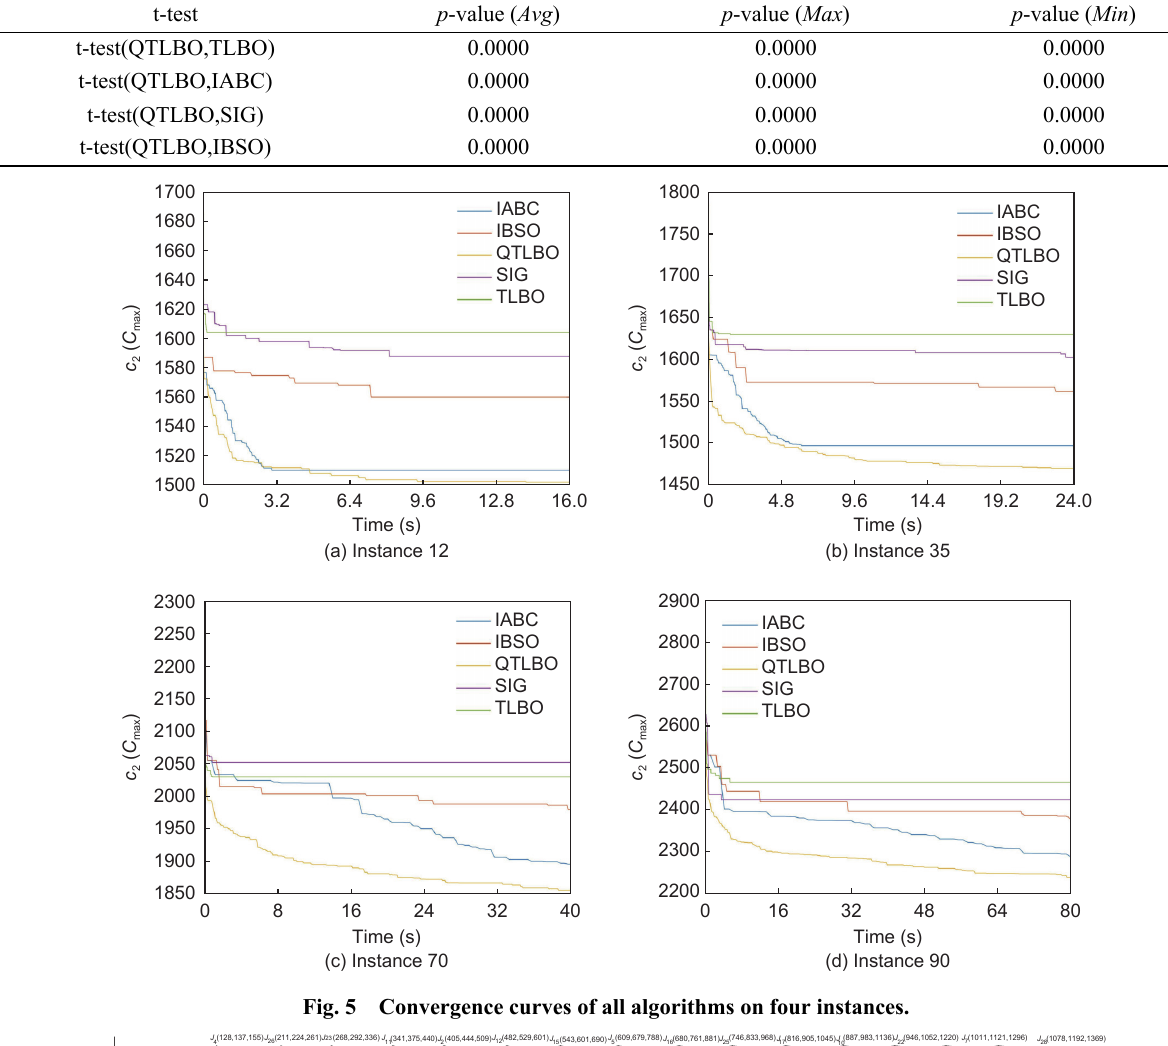
Fig. 5 Convergence curves of all algorithms on four instances.